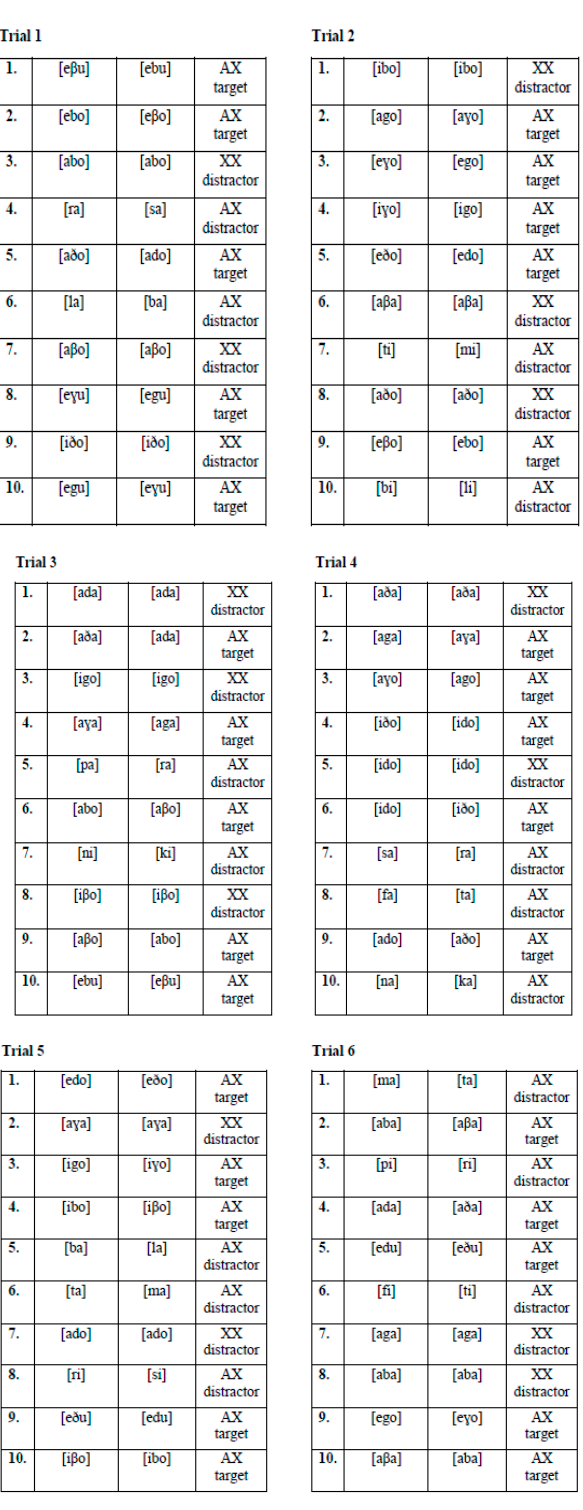
Figure A1. Perceptual stimuli randomized per trail.